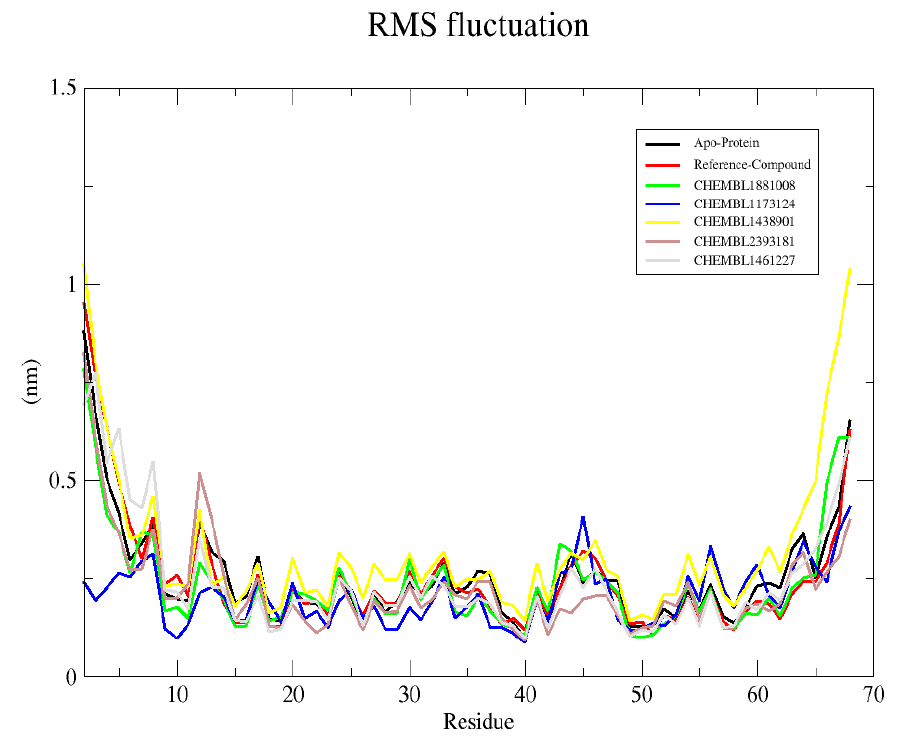
Figure 5. The RMSF graph of all complexes along with apo-protein during 50 ns MD Simulation.